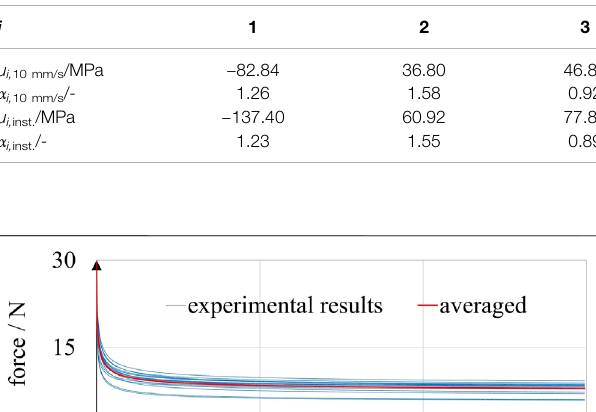
TABLE 1 | Material parameters for A30 PolyJet elastomer, obtained by fi tting a three-term Ogden material model to the original and modi fi ed results of uniaxial and planar tensile experiments. The implementation is straightforward in Abaqus/CAE and other nonlinear FE software.